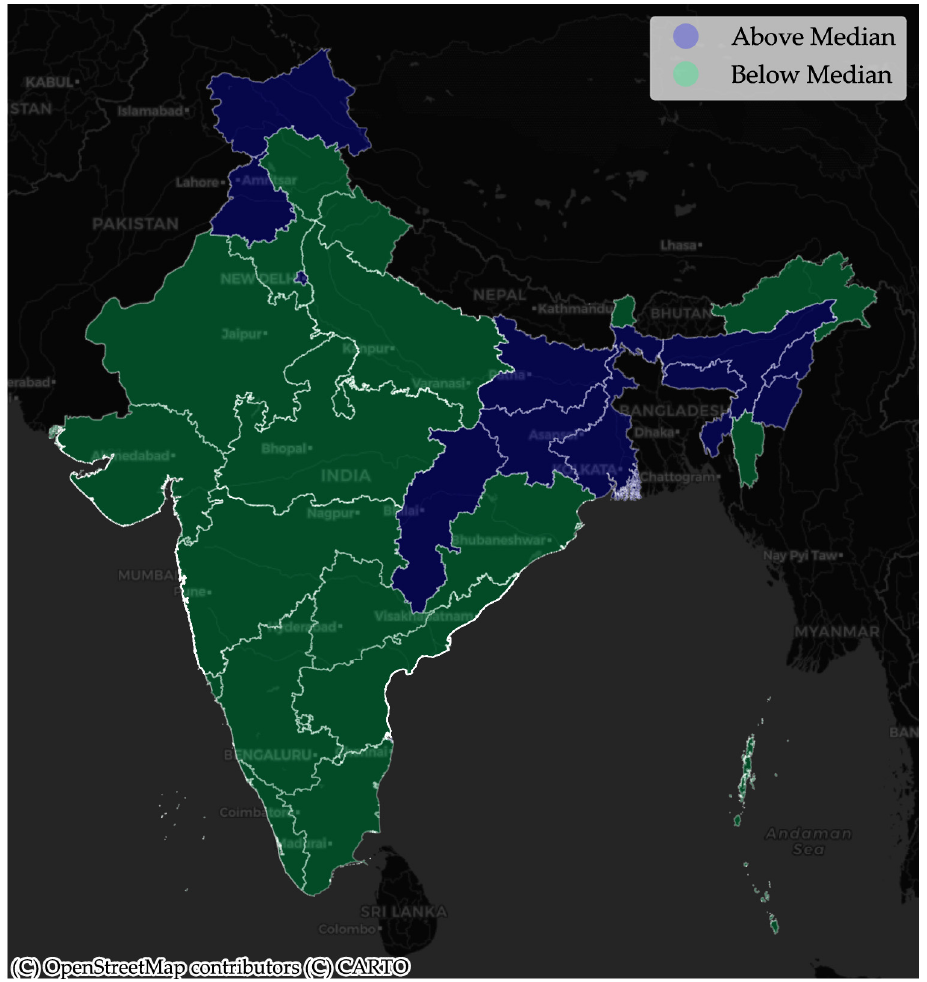
Figure 16. Segregation of Indian states using the GTI-IS density statistic.